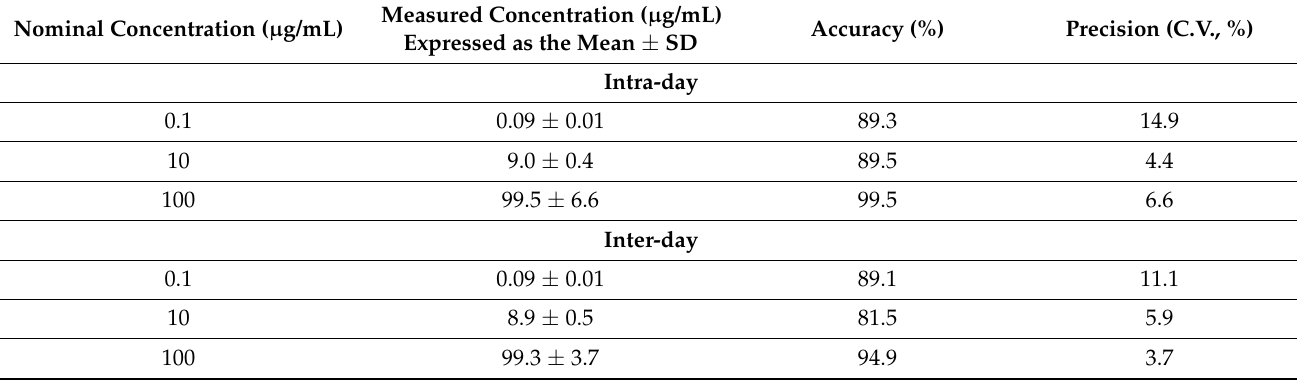
Table 1. Data on the intra- and inter-day precision and accuracy of the HPLC method for the quantification of C1 in rat plasma. The intra- and inter-day accuracy and precision were determined using different quality control samples ( n = 5) of C1 at distinct concentrations (0.1, 10, and 100 µ g/mL) on five consecutive days. Accuracy and precision were expressed in terms of relative error (RE) and relative standard deviation (RSD), respectively.